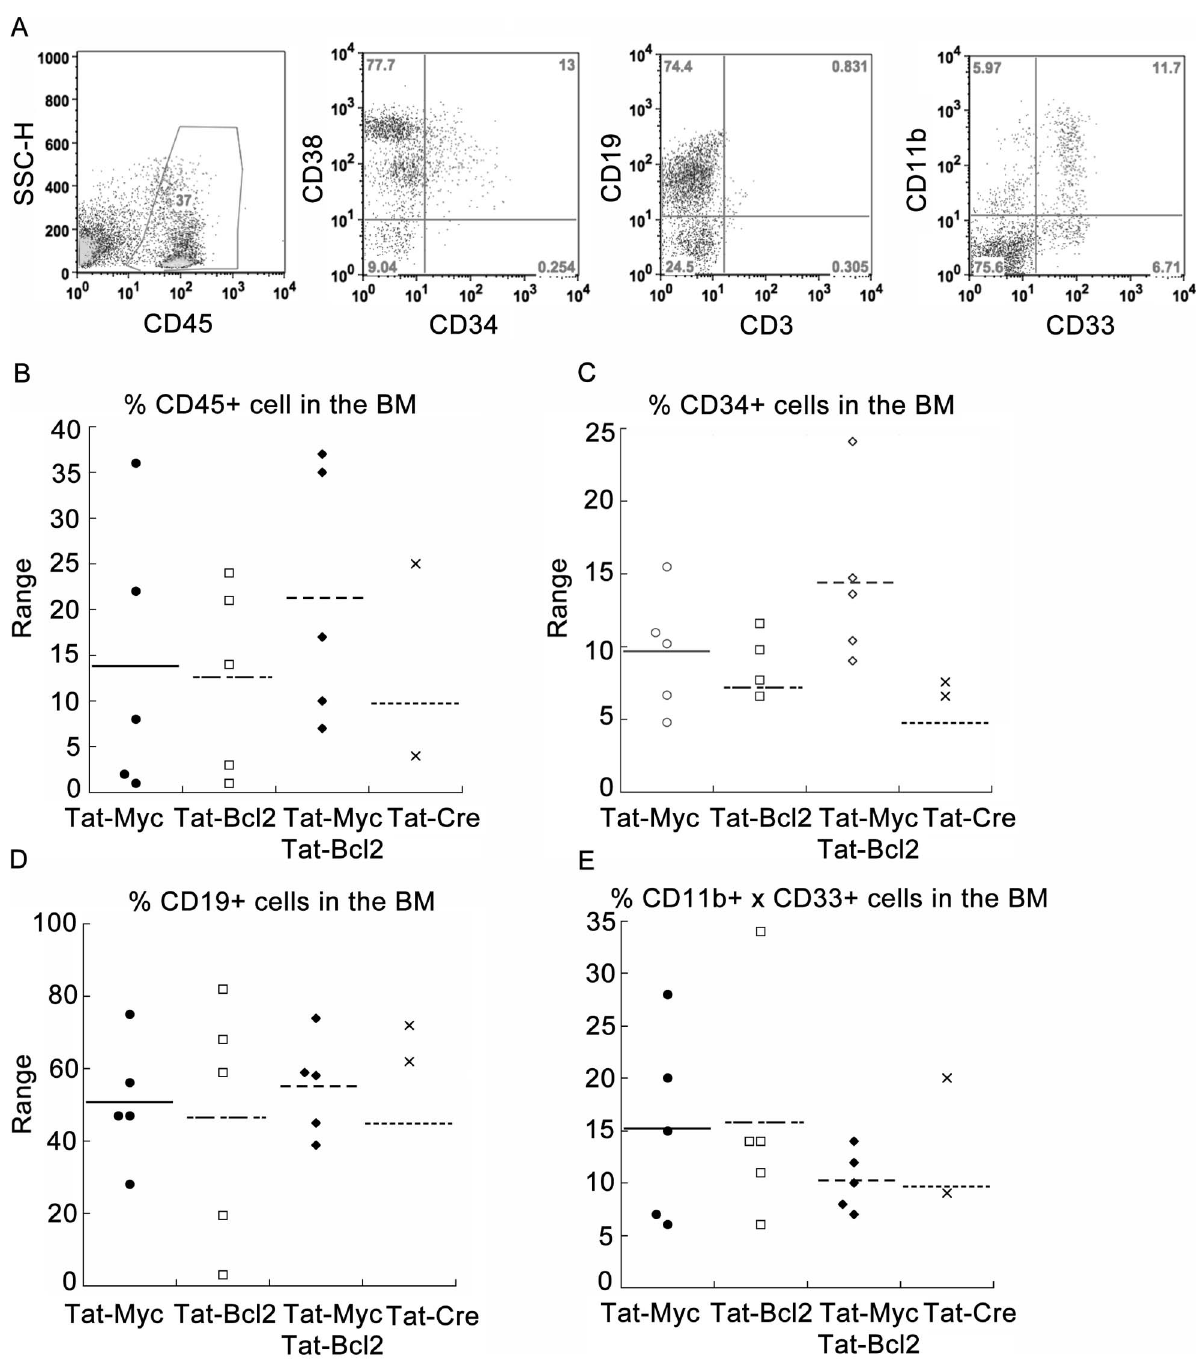
Figure 7. Comparison of NSG mouse engraftment with CD34 + cells isolated from human cord blood cells after expansion with Tat- MYC, Tat-Bcl-2, Tat-MYC/Tat-Bcl-2 or Tat-Cre. A. Cohorts of irradiated NSG mice were given transplants of 10 5 CD34 + cells isolated from CB expanded ex vivo in CB media supplemented with Tat-MYC/Tat-Bcl-2. The NSG xenochimaeric mice generated with isolated CD34 + cells were euthanized and used to collect bone marrow cells. The BM cells were stained for human hCD45 (1 st panel). Gating on CD45 + cells, we observed human CD34 + /CD38 + cells (2 nd panel), CD19 + cells (3 rd panel) and CD11b + /CD33 + cells (4 th panel) in the bone marrow. B. A dot plot representation of the percent CD45 + engraftment in the BM of mice transplanted of 10 5 CD34 + cells isolated from CB expanded ex vivo in CB media supplemented with Tat-MYC (black circles), Tat-Bcl-2 (open squares), Tat-MYC/Tat-Bcl-2 (black diamonds) or Tat-Cre (black X). C A dot plot showing the percent of CD45 + cells shown in B that stain positive for CD34. D and E. A dot plot showing the lineage positive engraftment in the BM of mice shown in B.